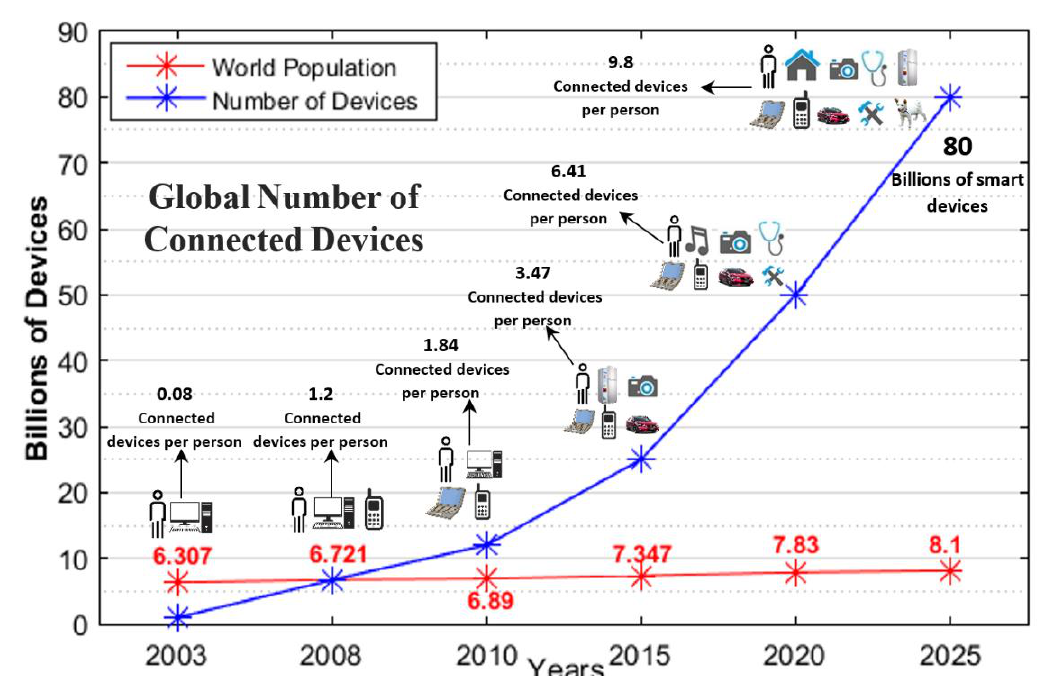
Figure 1. The current status and future perspective of the IoT.